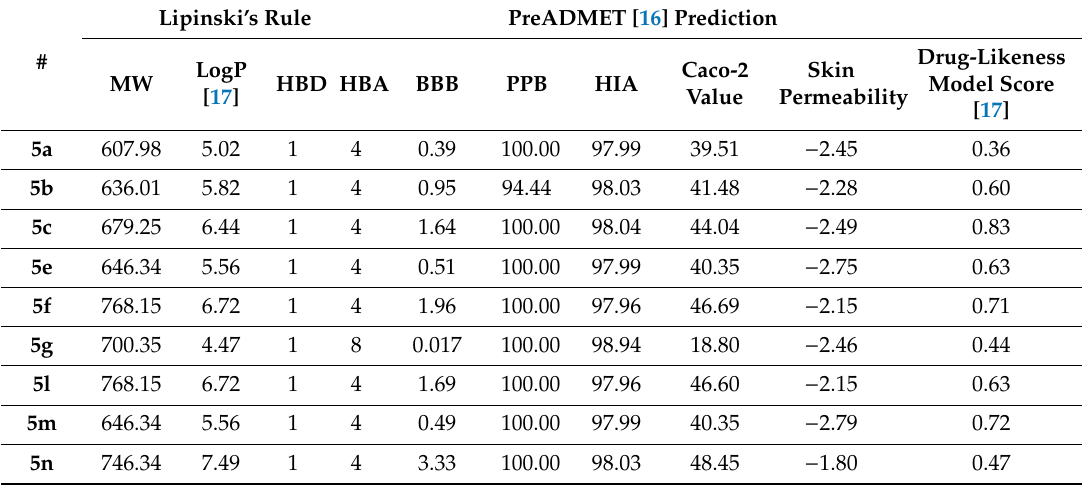
Table 2. Predicted pharmacokinetic and pharmacodynamic parameters of the most active compounds.